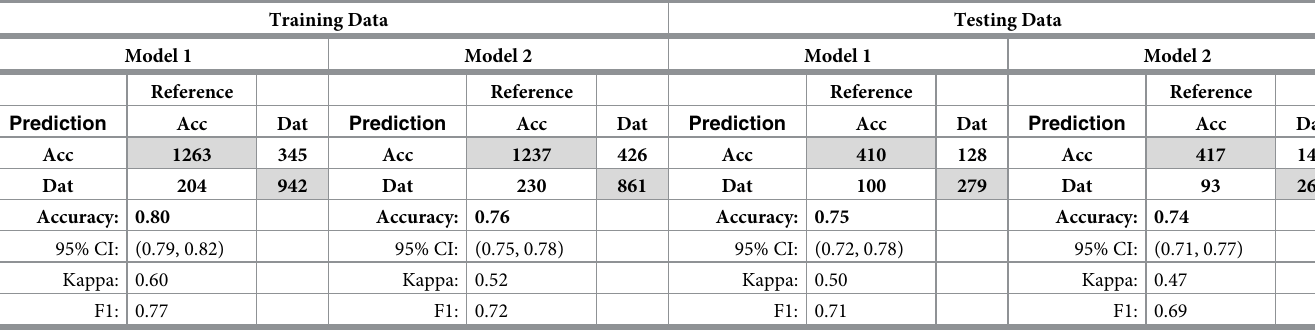
Table 7. Confusion matrices for Model-1 and Model-2 on training and testing